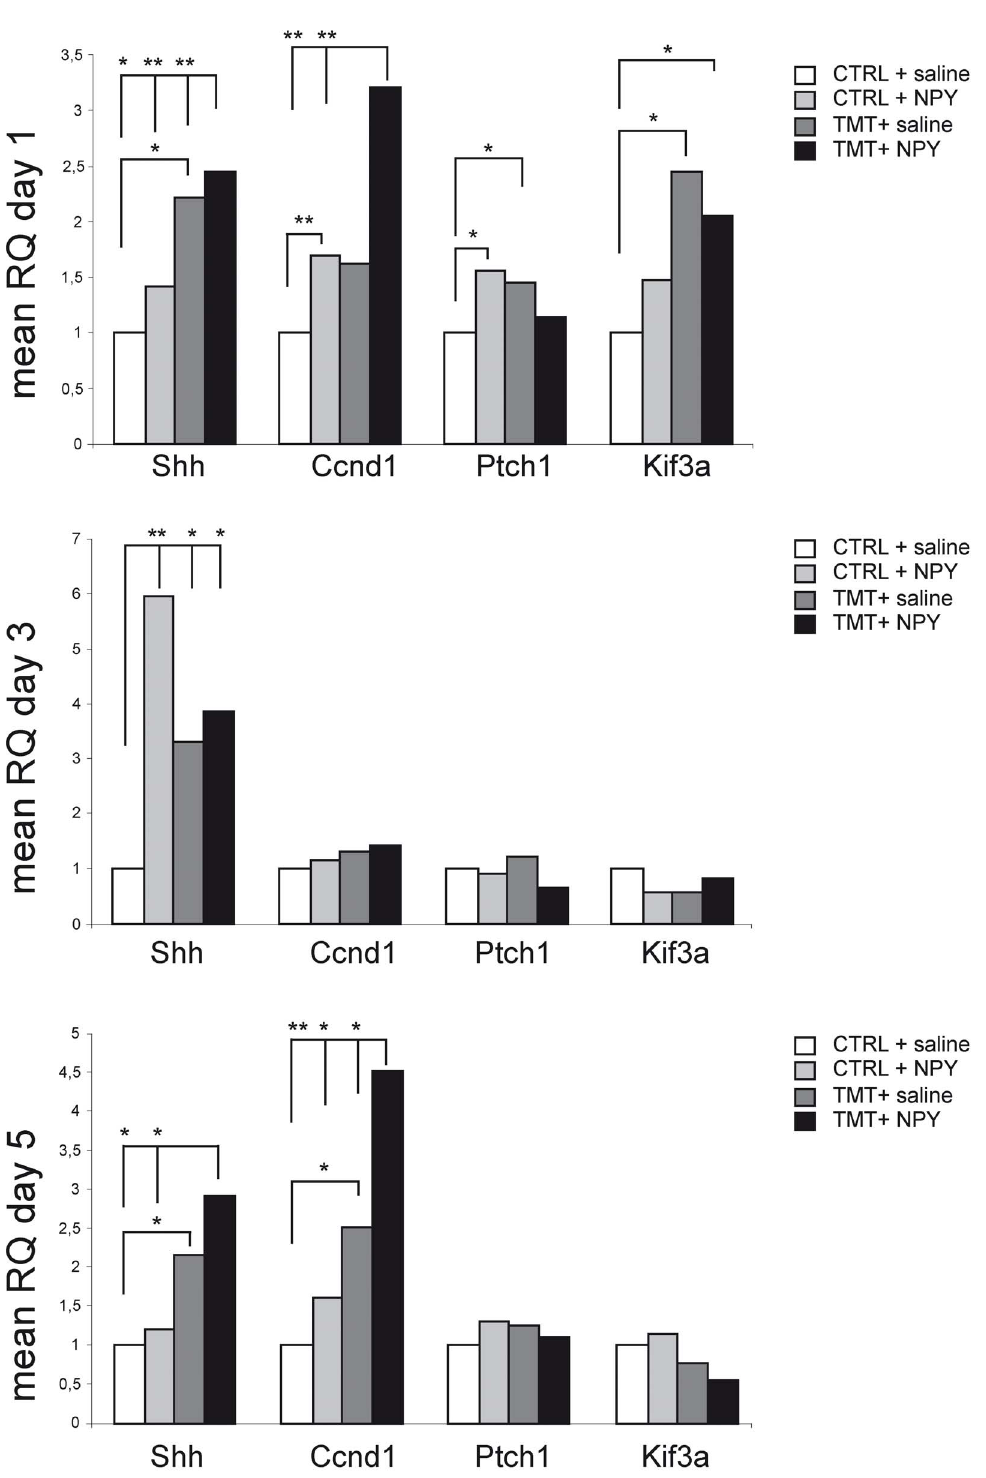
Figure 6. mRNA expression levels of genes related to the Shh pathway in rat hippocampus in the different experimental groups. Results of quantitative real time-PCR obtained using the DD Ct method for the calculation of relative quantity (RQ) of Shh, Ccnd1, Ptch1 and Kif3a genes at the three tested time points. *p , 0.05, **p , 0.001, calculated on mean D Ct across biological replicates. doi:10.1371/journal.pone.0088294.g006 derived neurotrophic factor, fibroblast growth factor-2, vascular that micro-environmental changes induced by epilepsy and/or endothelial growth factor, and also Shh) are upregulated in the neurodegeneration could strengthen the NPY-mediated influence hippocampus after acute seizures [77]. Thus we may speculate